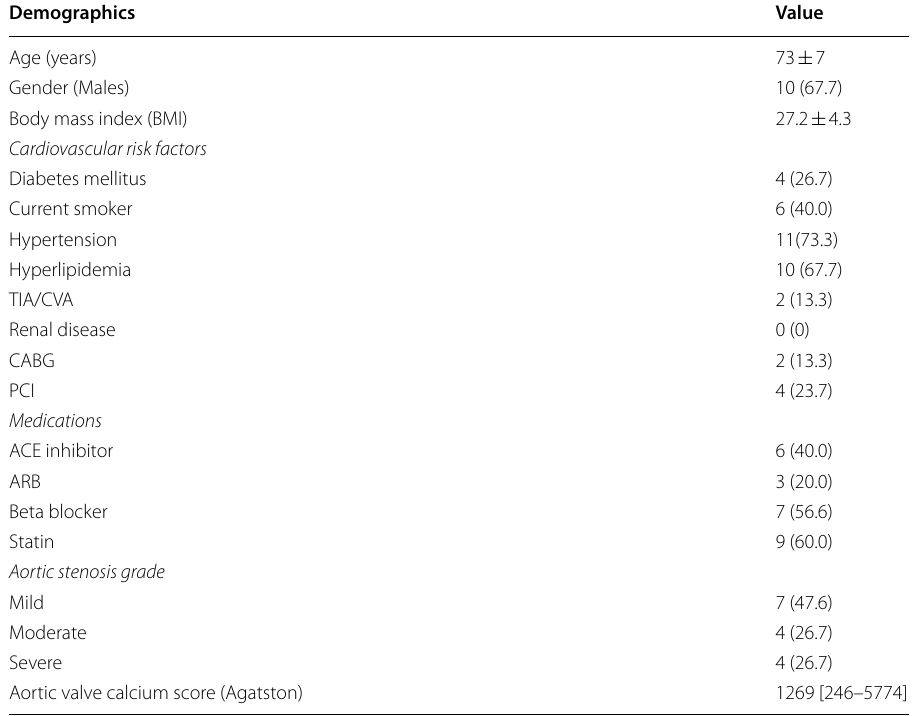
Fig. 3 SUV max and TBR max measurements obtained for the three reconstructions. Significantly increased SUV max and TBR max values were observed for the 3 ECG-MC datasets (Pitman–Morgan analyses, all p < 0.05). Standard motion-corrected, 3